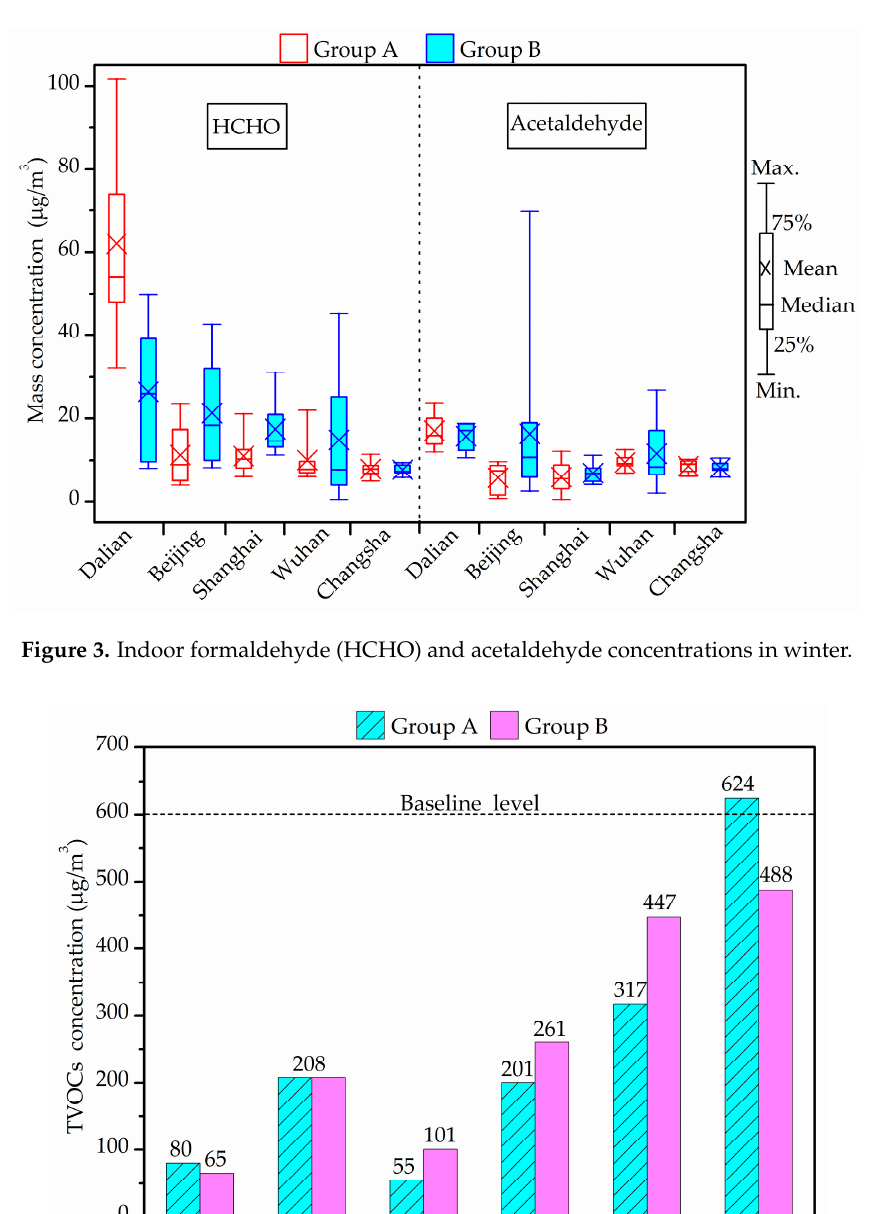
Figure 4. Indoor average total volatile organic compounds (TVOCs) concentrations in winter.